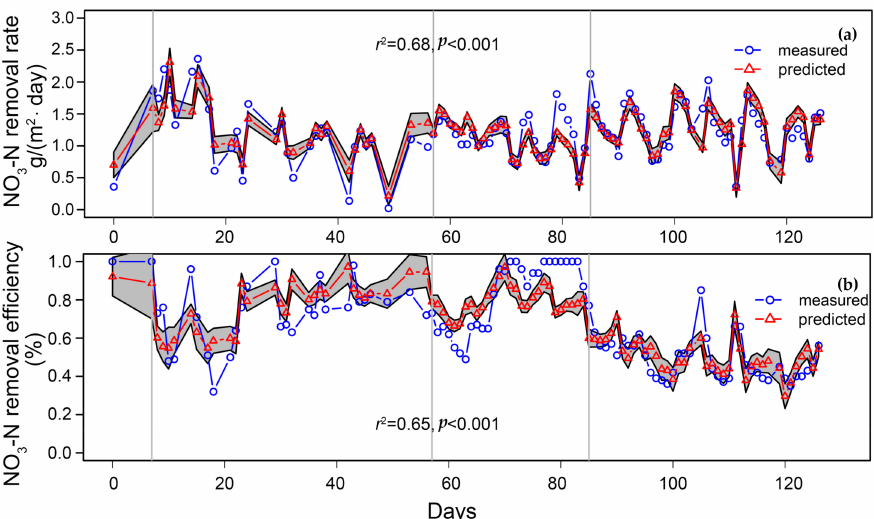
Figure 4. Measured (blue lines) and predicted (red line) values of nitrate removal rate and efficiency with multiple linear regression models. The grey zone is the 95% confidence of the interval of predicted values. ( a ) NO 3 -N removal rate ( b ) NO 3 -N removal